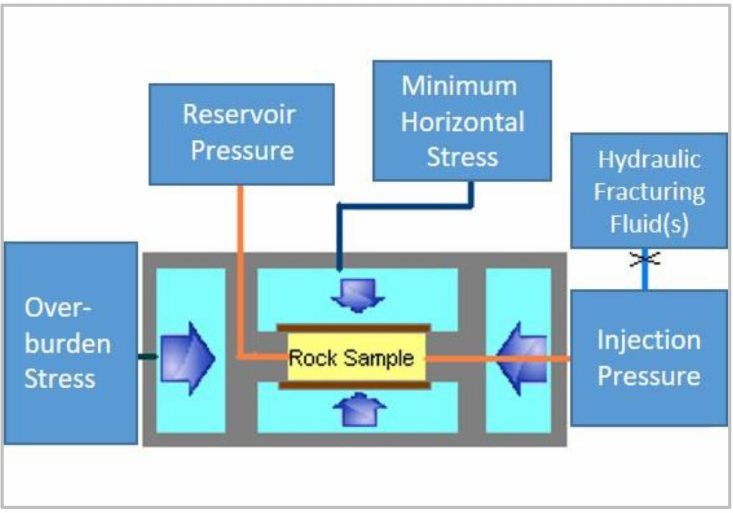
Figure 3. In-situ stresses and reservoir pressure in the frac-n-flow